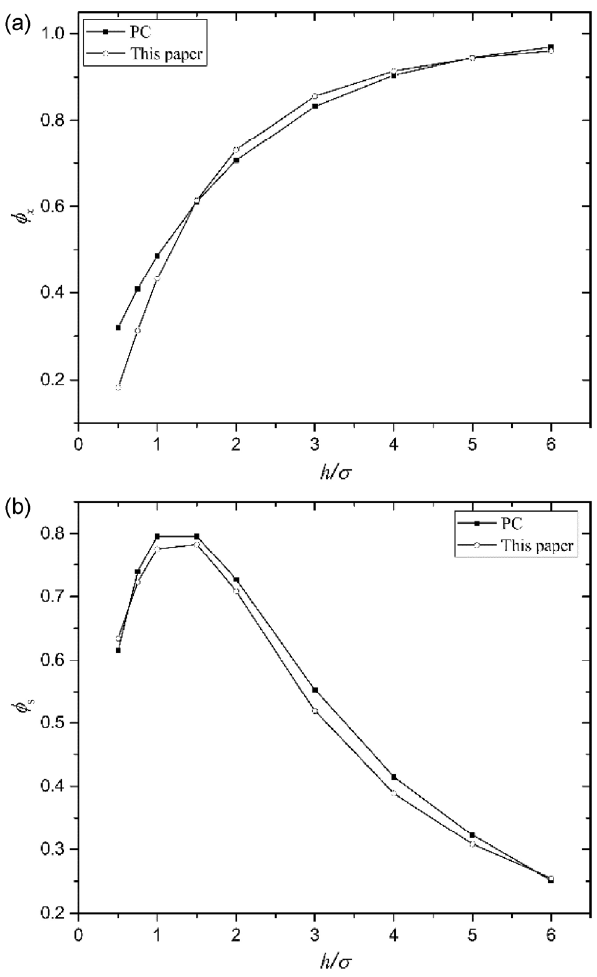
Fig. 4 Comparison of computed flow factors and Patir’s results Sk = 1, Ku    1. (a) Pressure flow factors, (b) shear flow factors.